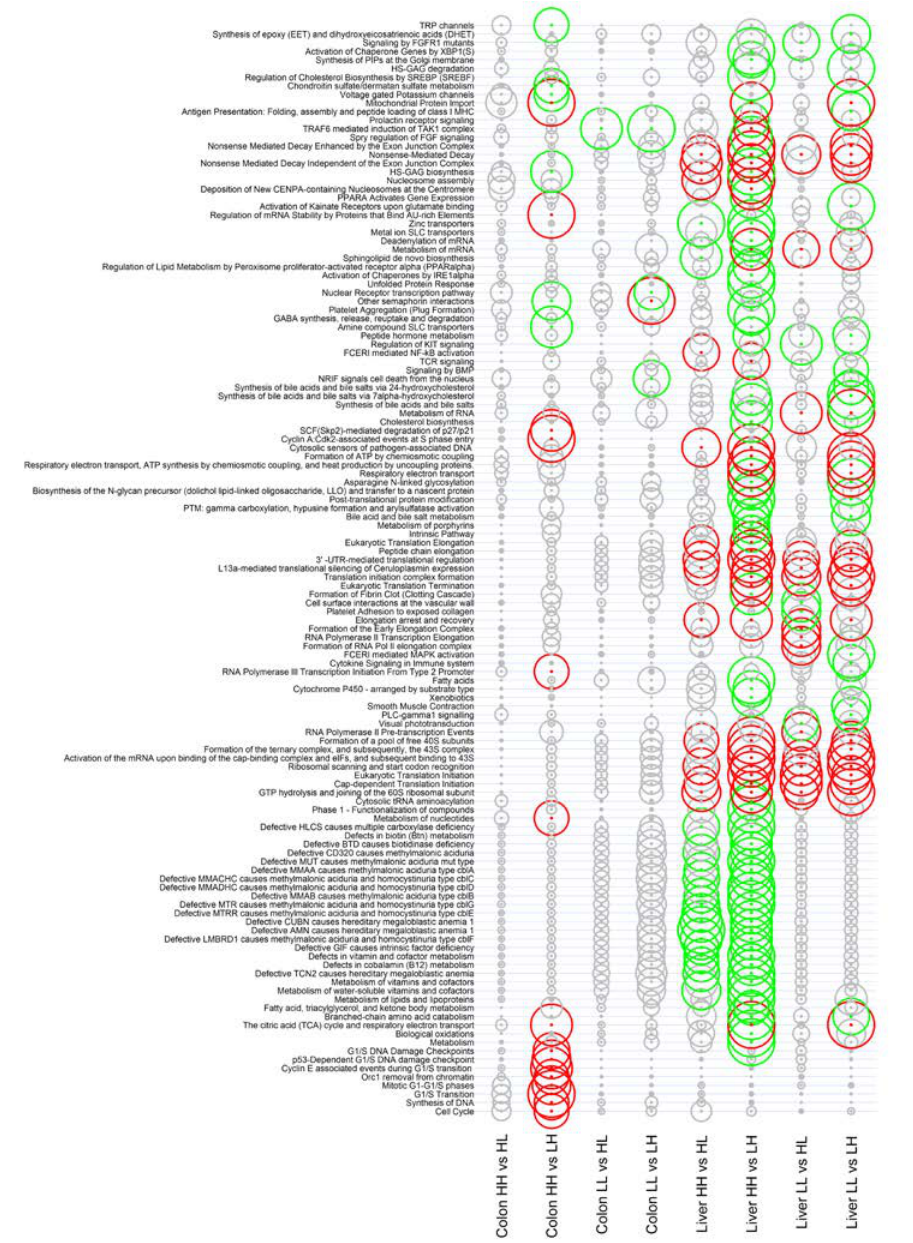
Figure 2. Gene set enrichment analysis (GSEA) of Reactome pathway expression. Size of the circles is proportional to significance (log odds), with increased circle diameter indicating increased significance. Pathways showing difference in expression with significance < 0.01 ( i.e. , log odds > 2) are coloured red or green depending on the direction of expression shift. Red indicates significantly higher expression in first group, while green indicates higher expression in second group. GSEA of liver comparisons are shown in Tables S3 and S5, differentially expressed genes in the liver are listed in Tables S4 and S6, and GSEA of colon is shown in Table S7. Data represent comparisons between treatments with n = 6 animals in each treatment